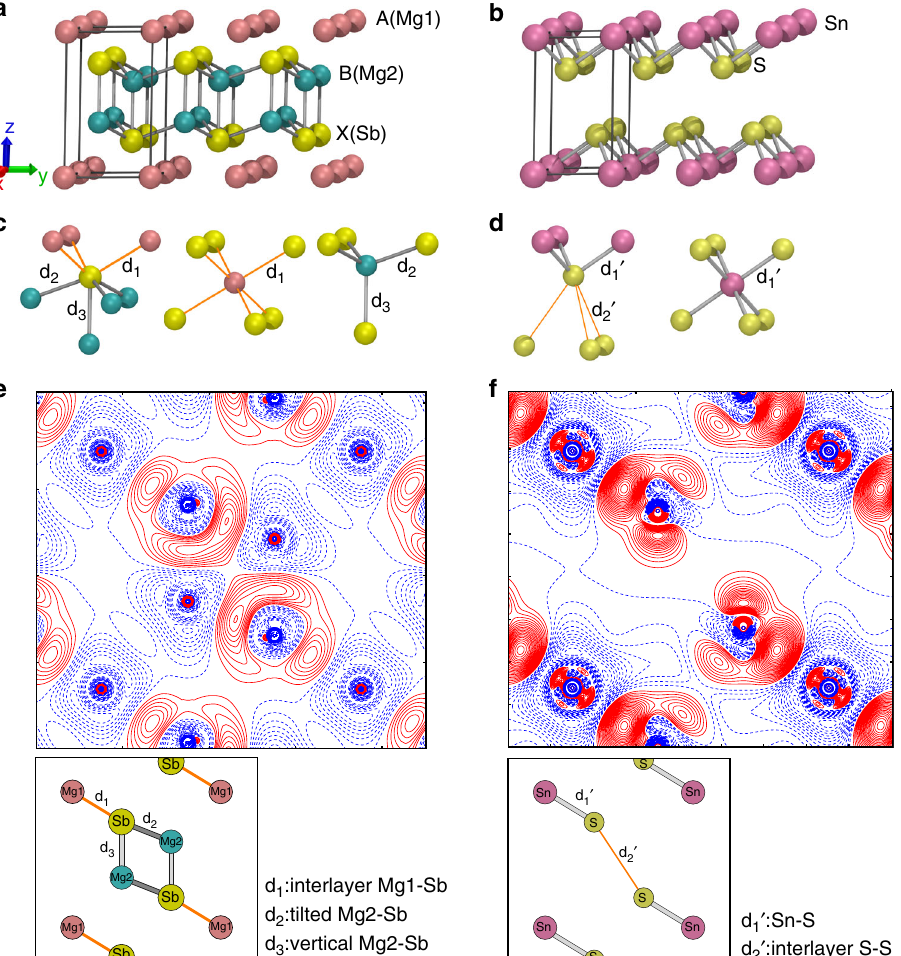
Fig. 1 Crystal structure and static deformation electron density. a , b Crystal structure of ( a ) AB 2 X 2 (Mg 3 Sb 2 ) and ( b ) SnS 2 . Mg1 and Mg2 represent Mg atoms in the Mg monolayer and [Mg 2 Sb 2 ] 2 − layer, respectively. c , d Coordination polyhedrons of the nonequivalent atoms in ( c) AB 2 X 2 (Mg 3 Sb 2 ) and ( d ) SnS 2 . e , f Static deformation electron density map on (110) plane containing both interlayer and intralayer interactions of ( e ) Mg 3 Sb 2 and ( f ) SnS 2 . The contour interval is 0.006 e Å − 3 . Positive (negative) contours are plotted with red full (blue dotted) lines. The inset shows the corresponding (110) plane